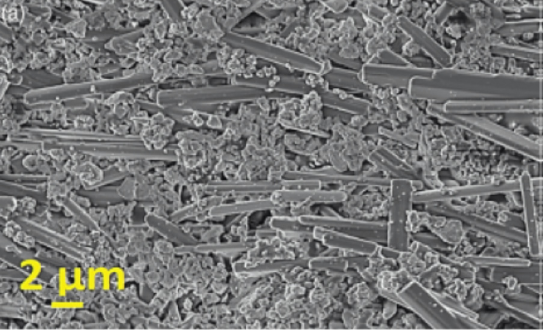
Figure 12. SEM image a single tape containing well-aligned Na 2 Ti 6 O 13 template whiskers embedded in the base matrix powder [129].